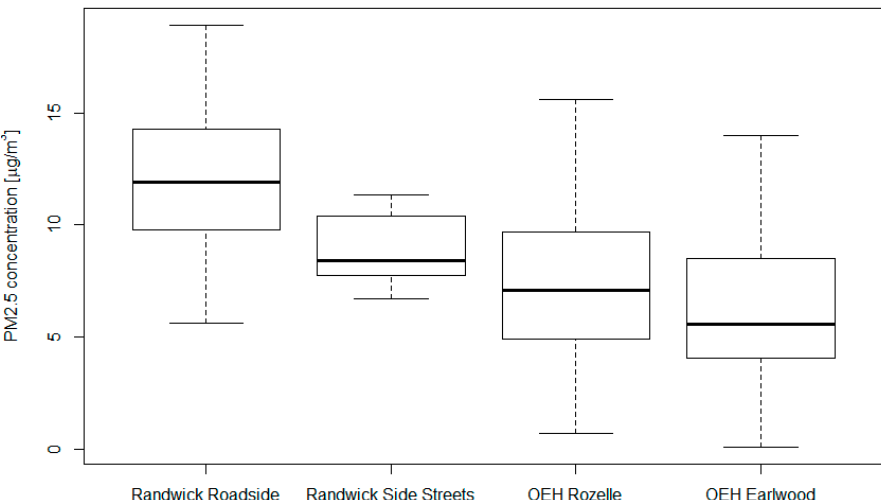
Figure 8. Data averaged across the whole of the Roadside Atmospheric Particulates in Sydney (RAPS) campaign’s sampling times, along Anzac Parade (Randwick Roadside), on University Avenue and Day Avenue (Randwick Side Streets), and at Rozelle and Earlwood O ffi ce of Environment and Heritage (OEH) monitoring stations. The black lines are the median values, and the box includes the upper and lower quartiles (inter-quartile range). The whiskers extend to 1.5 × the inter-quartile range. For clarity, outliers were removed from the figure if they exceeded beyond the edge of the